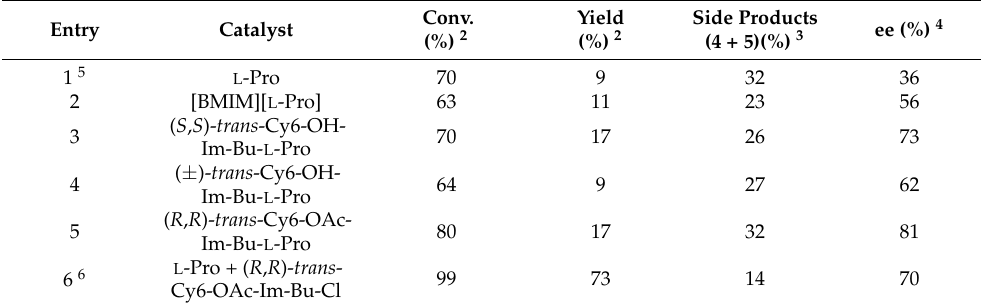
Table 2. Results for the aldol reaction between p -nitrobenzaldehyde and acetone with